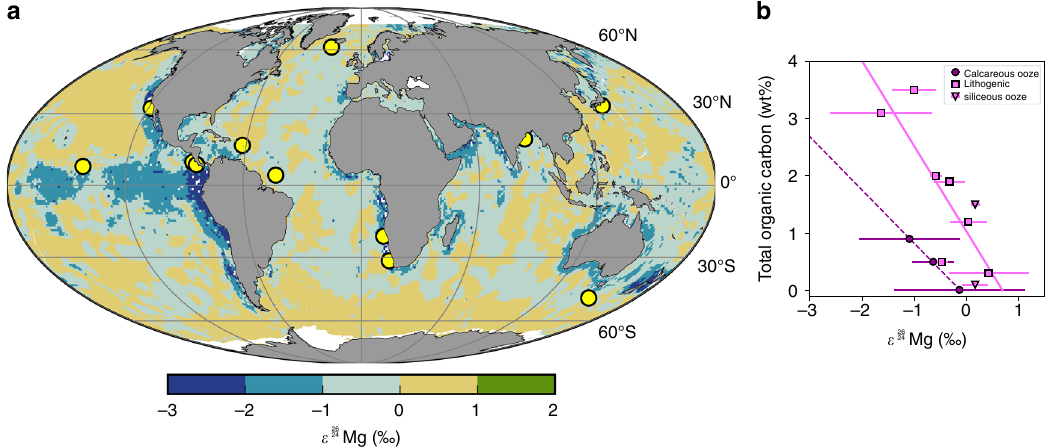
Fig. 2 Fractionation of magnesium isotopes into marine sediments. a Global distribution of the isotopic fractionation of magnesium isotopes associated with the magnesium fl ux into the marine sediment column. Yellow dots are the thirteen ocean drilling locations where the fractionations are calculated. b Isotopic fractionation of magnesium isotopes plotted versus total organic carbon in the upper sediment column. Linear regressions are fi t to the data for calcareous sediments (dark purple, n = 3, R 2 = 0.9996, p < 0.05), and siliceous sediments (light purple, n = 10, R 2 = 0.8171, p < 0.05) separately. Circles are calcareous oozes, squares are lithogenic sediments, and triangles are siliceous oozes. Epsilon values are for fractionation from the ocean bottom water into the sea fl oor. Error bars represent the 1 σ standard deviation of the epsilon values. Gridded source data for Fig. 1a are provided as a Source Data fi